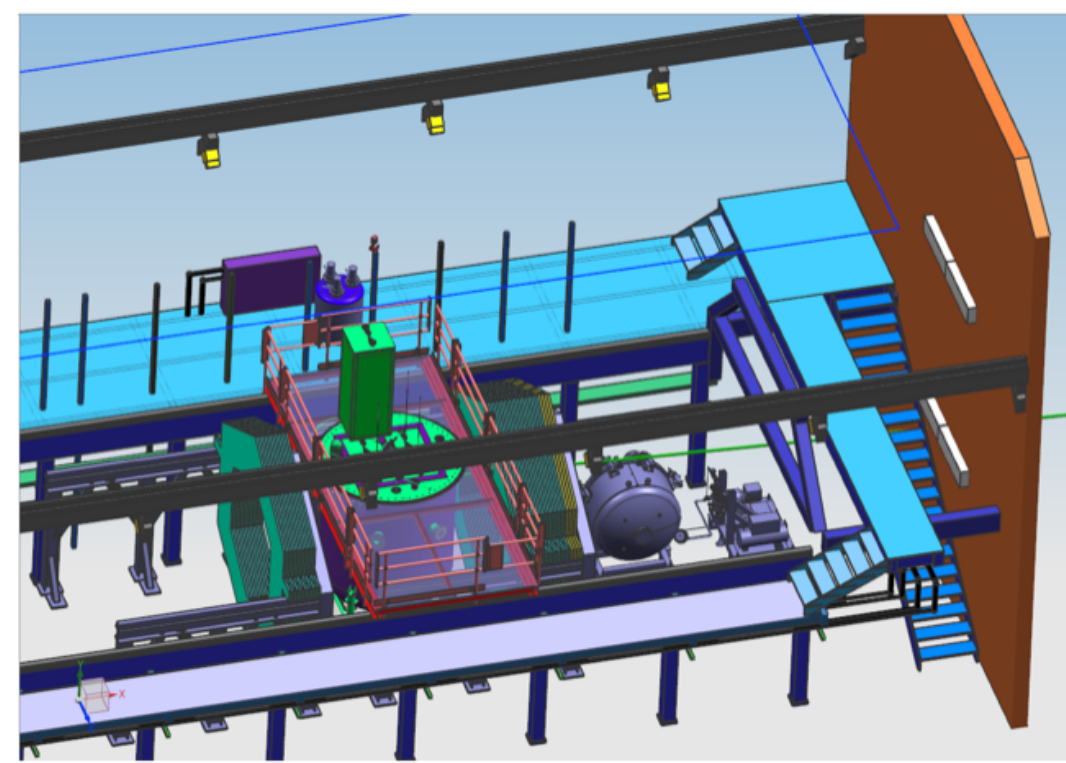
Figure 18. A drawing of the ArgonCube demonstrator deployed in the MINOS ND hall at Fermilab, forming ProtoDUNE- ND. One module is shown in the extracted position. The neutrino beam is incident from the left. Sections of MINERvA are shown upstream and downstream of the demonstrator. A prototype of the gas TPC of ND-GAr is also shown at the downstream